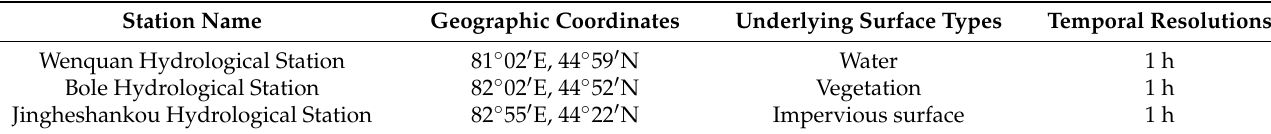
Table 2. Ground station